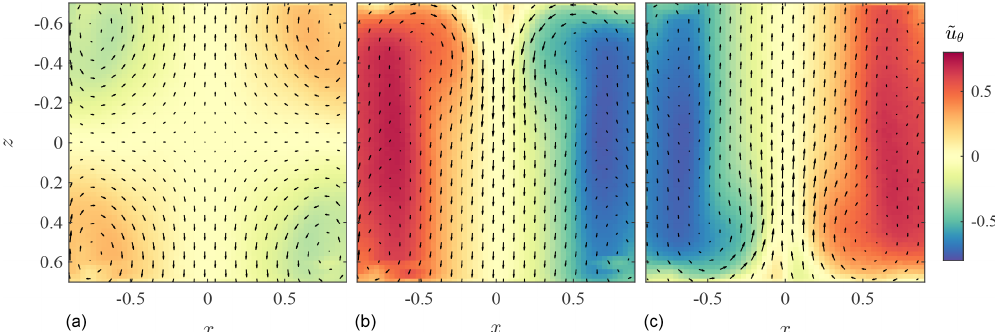
Figure 3. Different states observed in our system. (a) Two-cell symmetric state (“spring” or “autumn” transition, or “T”, state). (b) One-cell asymmetric state b + (“austral summer”, or “A”, state). (c) One-cell asymmetric state b − (“boreal summer”, or “B”, state). The normalized azimuthal flow ˜ u θ = 2 u θ /R(f 1 + f 2 ) is shown in colour (from negative blue to positive red), while the radial and vertical speeds (u r ,u z ) are represented by arrows. The resolution of the fields has been degraded for better visibility. The positions x and z have been rescaled by the radius of the cylinder R . The higher amplitudes in (b) and (c) with respect to (a) reflect a fundamental energetic difference linked to the very strong shear layer appearing at the interface between the flow, rotating in the direction of the dominant impeller, and the slave impeller, which rotates otherwise. As a result, the energy dissipation is 4 times larger in (b) and (c) with respect to (a)